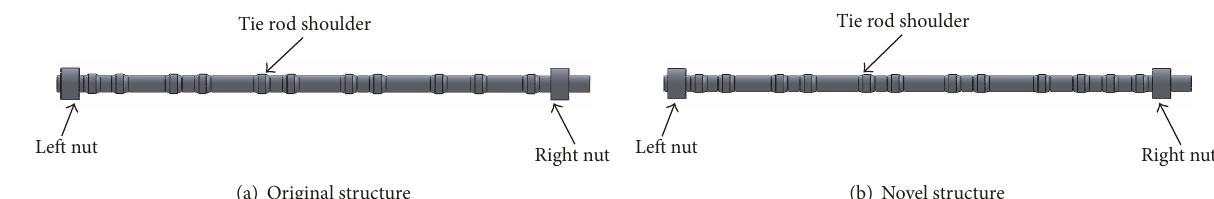
Figure 26: The novel tie rod